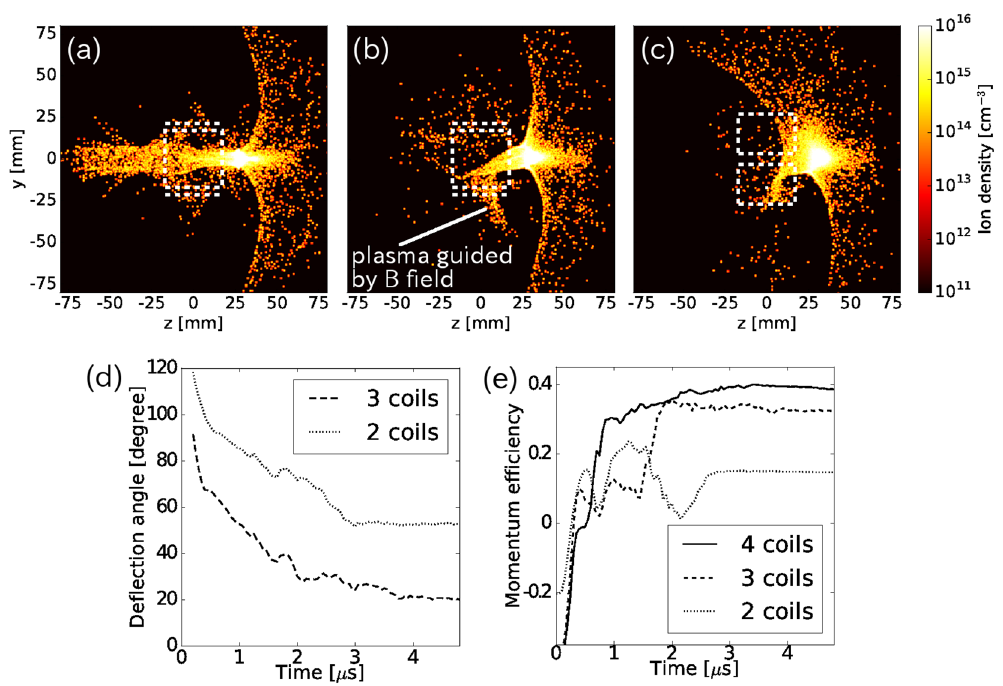
Figure 4. Simulation results from a combined calculation of two-dimensional radiation hydrodynamic and three-dimensional hybrid simulations. Ion density distribution in the unit of cm − 3 on the plane x = 0 with ( a ) all four coils, ( b ) the three lower coils, and ( c ) two coils at t = 0.5 μ s. Time-evolutions of ( d ) the deflection angle: θ